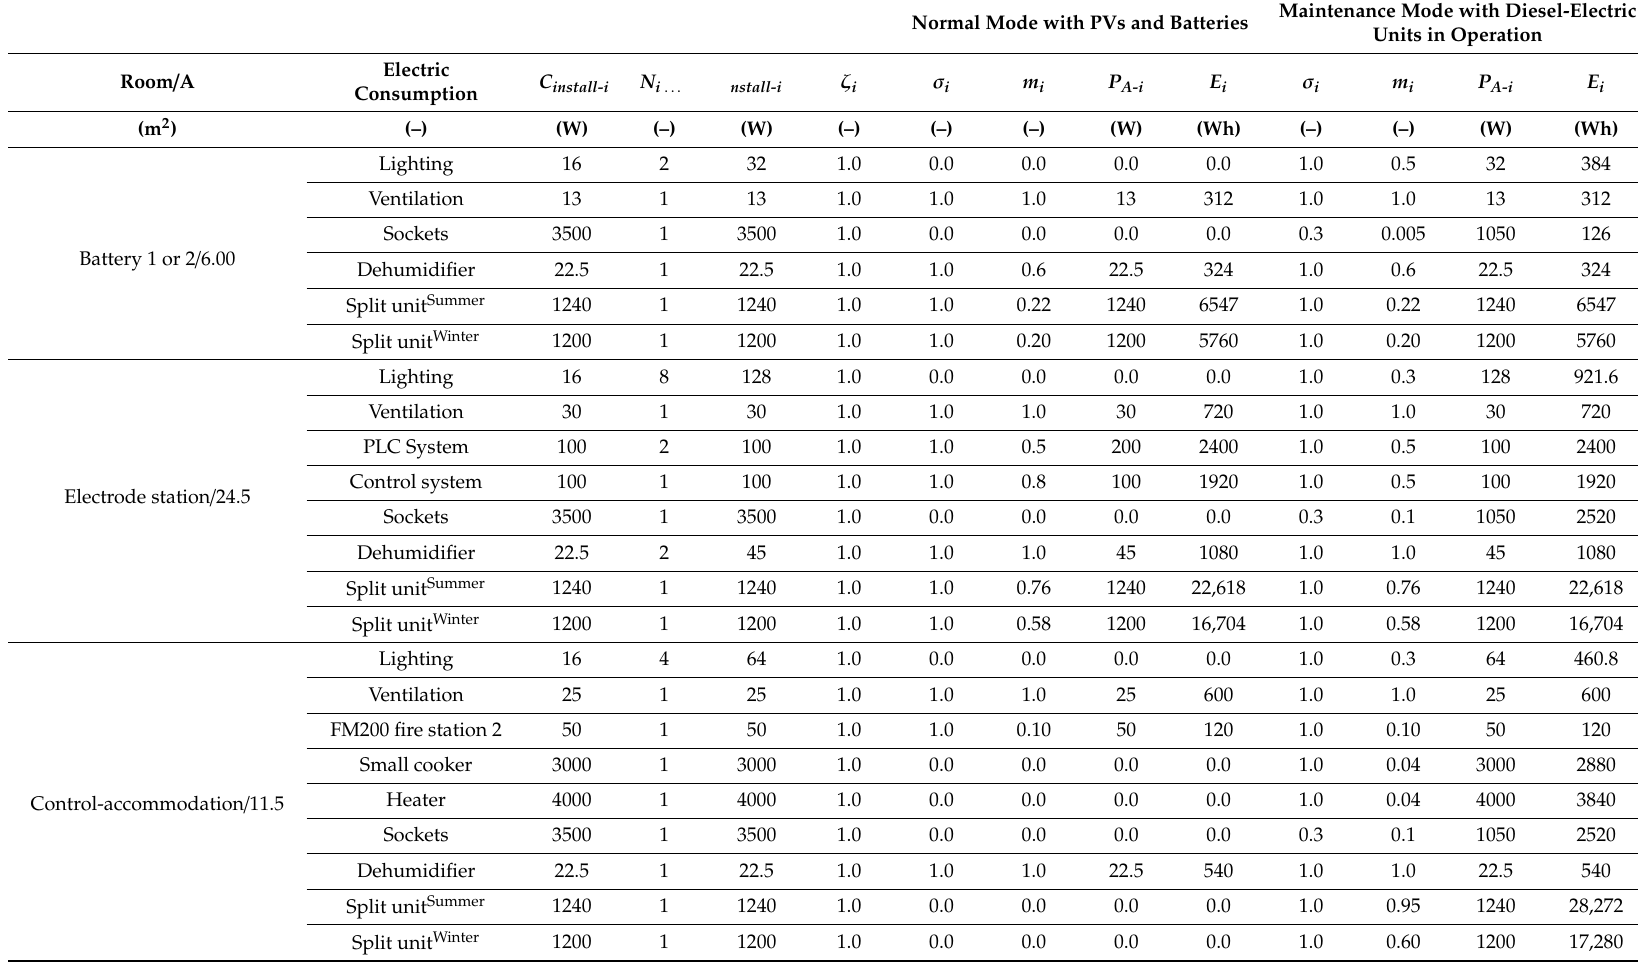
Table 2. Daily peak power and energy consumption for the electrode station in Stachtoroi Island,